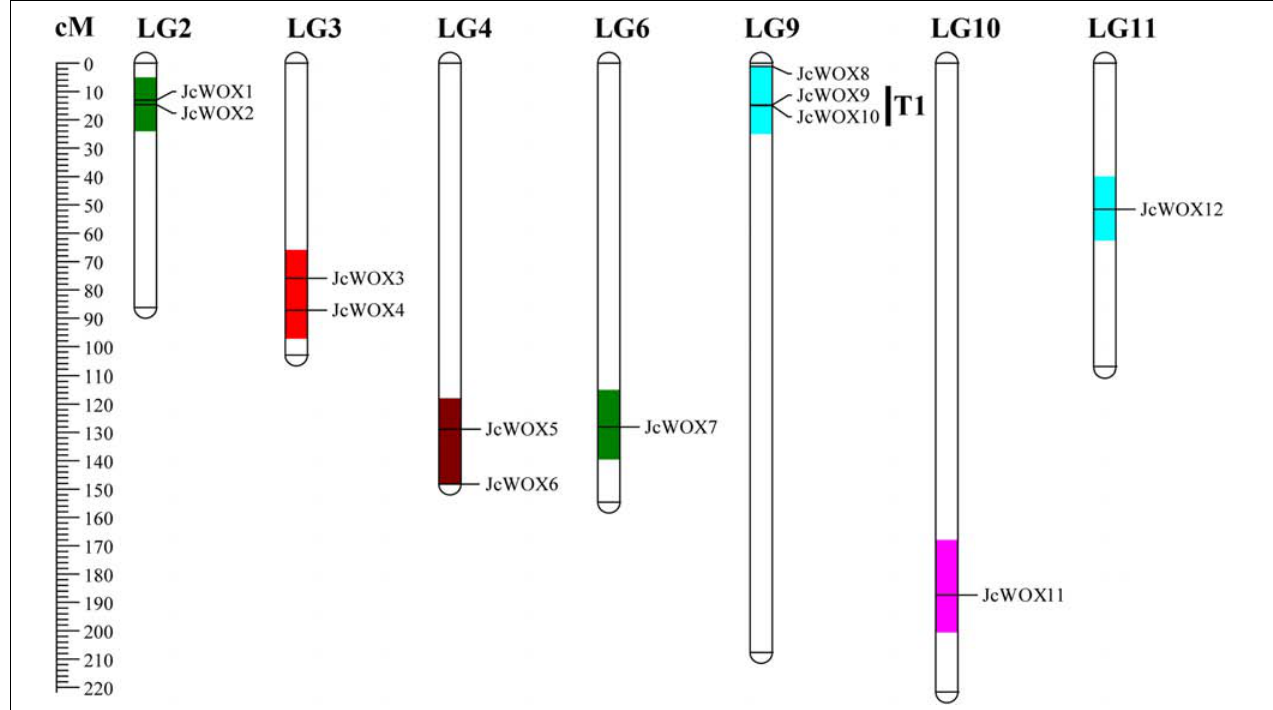
FIGURE 3 | Schematic representations for the chromosomal distribution of physic nut WOX genes. The scale is in centiMorgans